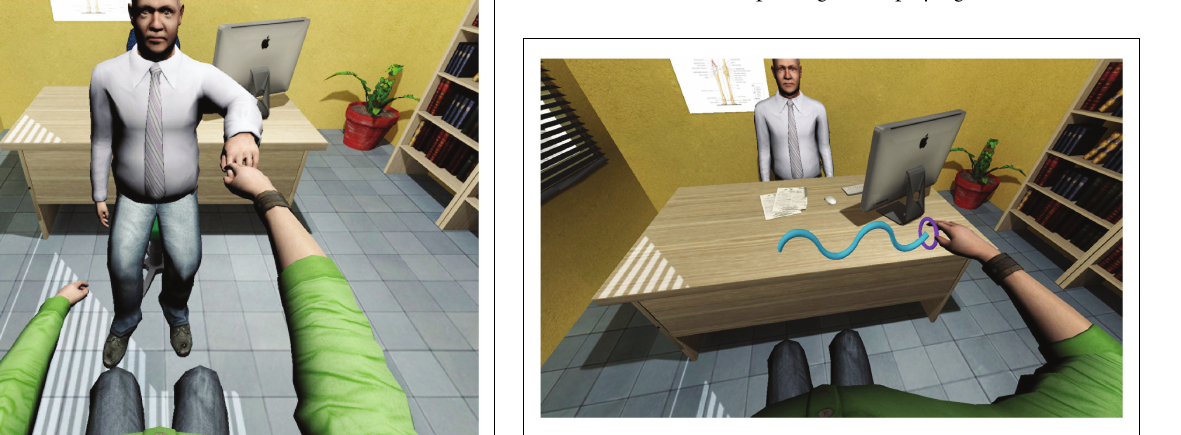
FIGURE 3 | Person-to-person haptic interaction with force-feedback. The remote doctor explores patient’s arm mobility.The patient sees a virtual representation of the real doctor, which gives the hand to him.